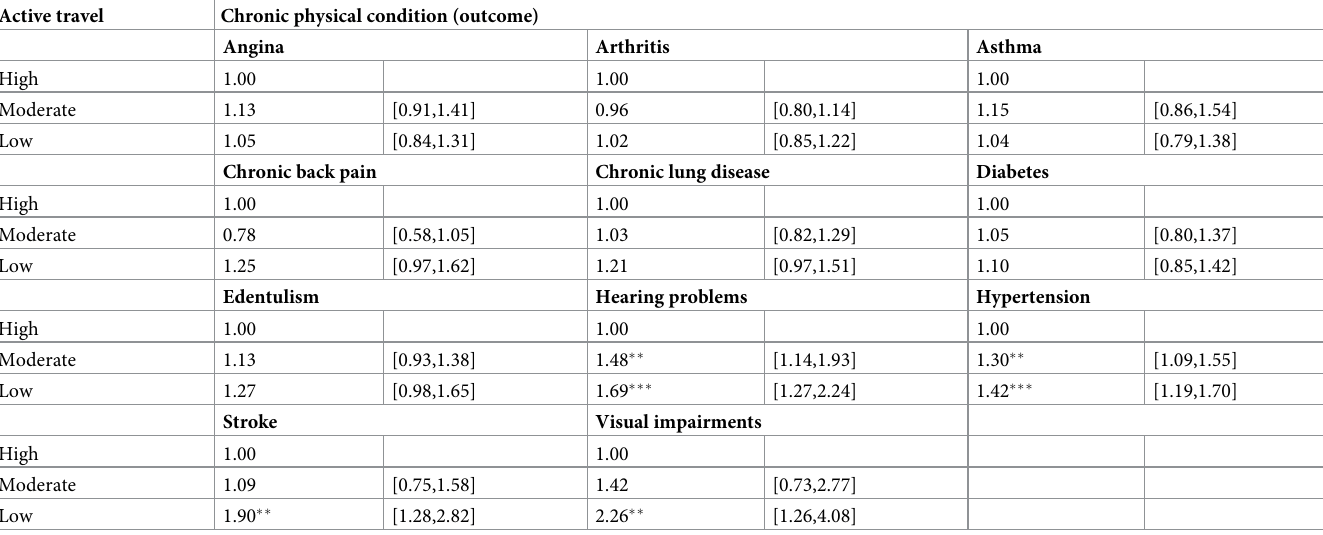
Table 4. Association between active travel and individual chronic physical conditions estimated by multivariable logistic regression. Active